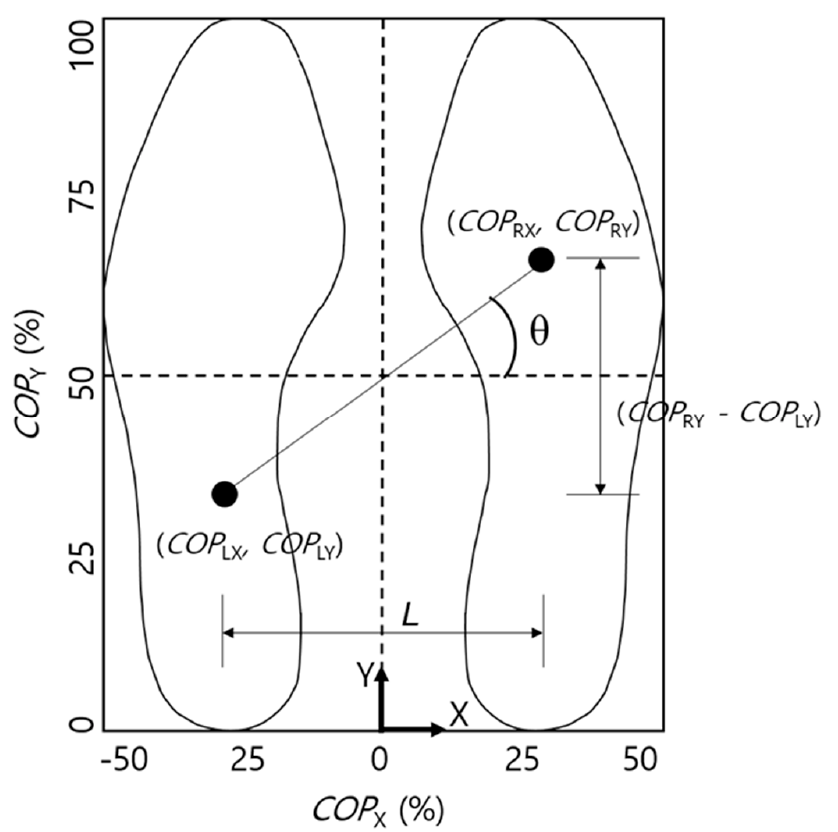
Figure 2. Schematic of center of pressure ( COP ) gradient. As shown in Figure 2, as the participants began walking, the positions of the COPs of the left and right feet, projected on the surface, shifted by repeatedly alternating between the forward/backward directions. The angle ( θ ) was formed by the segment connecting these two points and the frontal plane, and COP gradient was calculated using the equation below. In this equation, L, which was defined as the distance between the left and right feet, was assumed to be the same as the width of the hips (Figure 2), and its value was set based on the height of the participant